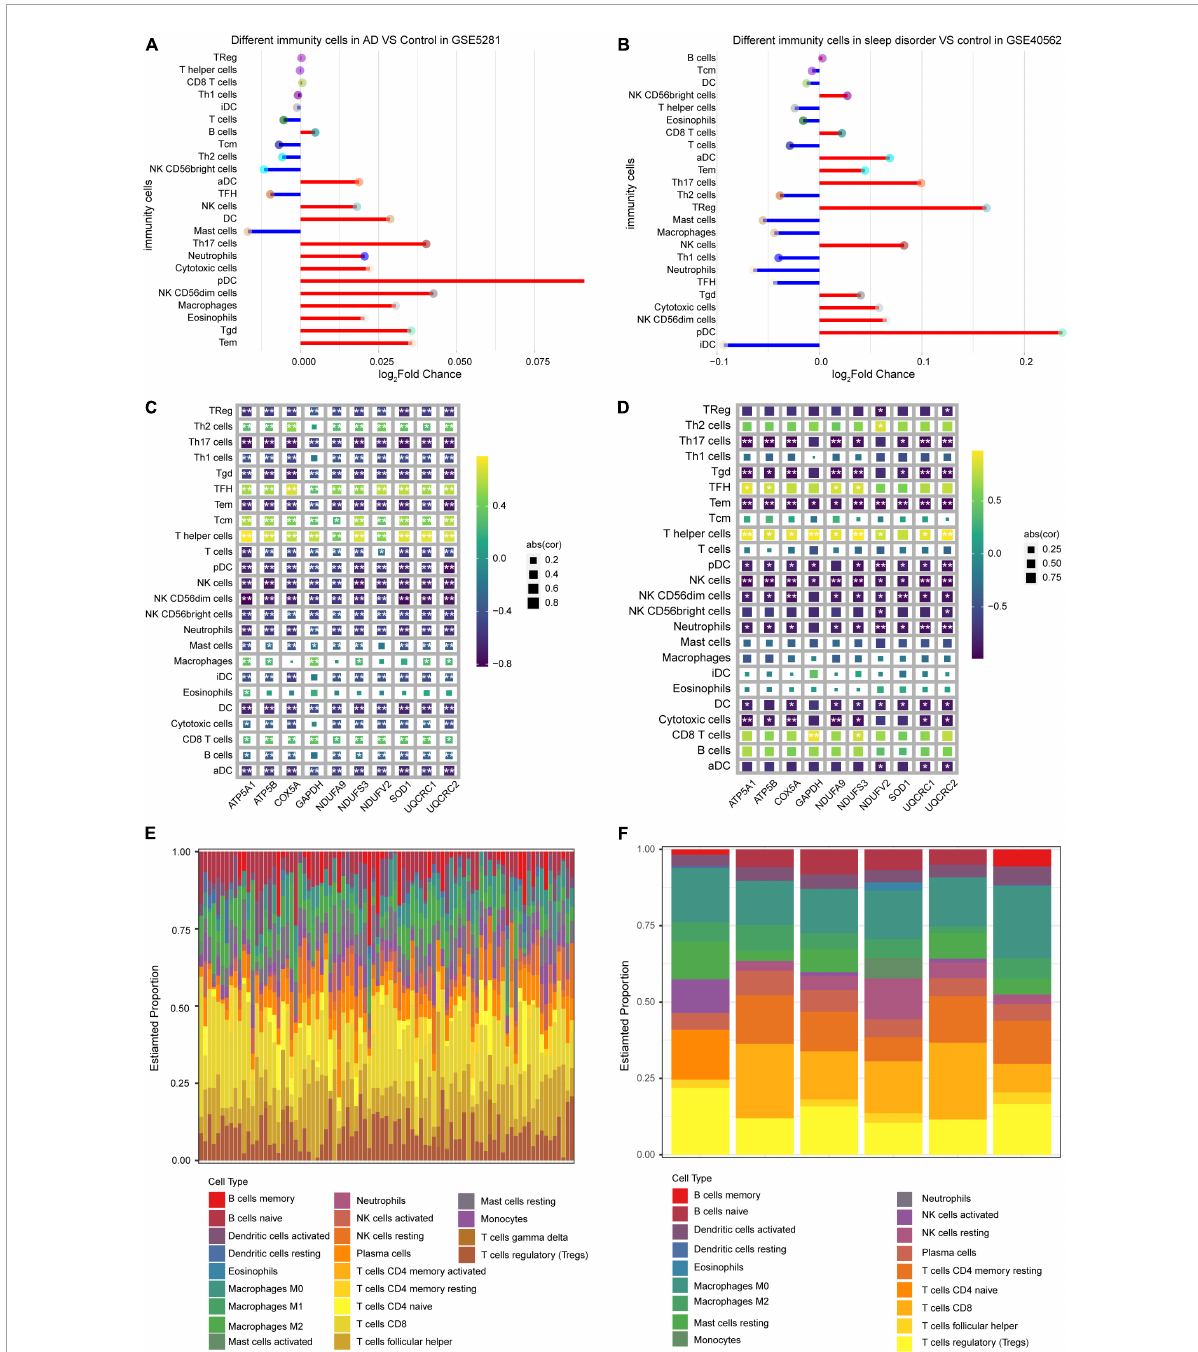
FIGURE6 Level of immune cell infiltration in Alzheimer’s disease (AD) and sleep disorder. Comparison of immune cell infiltration (A) between AD patients and controls, and (B) between sleep disorder patients and controls, based on ssGSEA. Plots of correlations between hub genes and immune cell types in (C) AD and (D) sleep disorder. Proportions of 22 types of infiltrating immune cells in (E) AD and (F) sleep disorder, based on the CIBERSORT